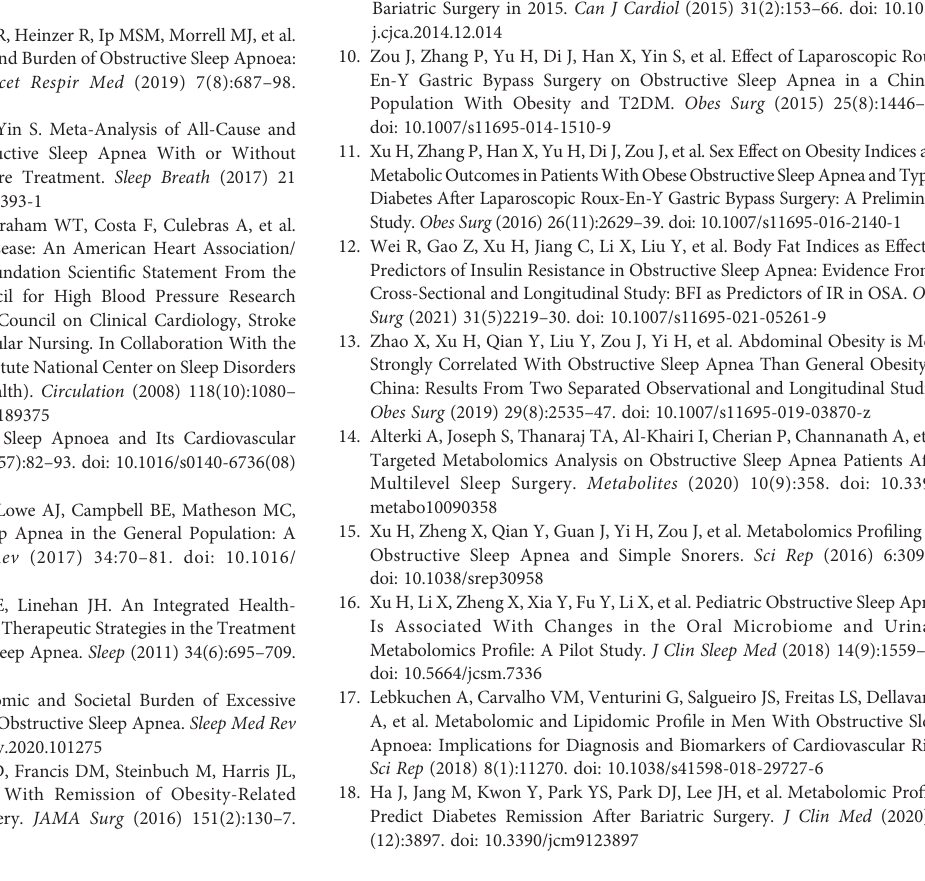
Supplementary Figure 3 | Heatmap based on the Spearman correlation matrix demonstrated clear correlations between the clinical indicators and metabolomic pro fi les of OSA remission patients before and after RYGB. OSA, obstructive sleep apnea; RYGB, Roux-en-Y gastric bypass surgery; SaO2, pulse oxygen saturation; BMI, body mass index; AHI, apnea – hypopnea index; ESS, Epworth sleepiness score; ODI, oxygen desaturation index; MAI, micro-arousal index; SBP, systolic blood pressure; DBP, diastolic blood pressure; FBG, fasting blood glucose; GHb, glycated hemoglobin; GA, glycated albumin; HOMA-IR, homeostasis